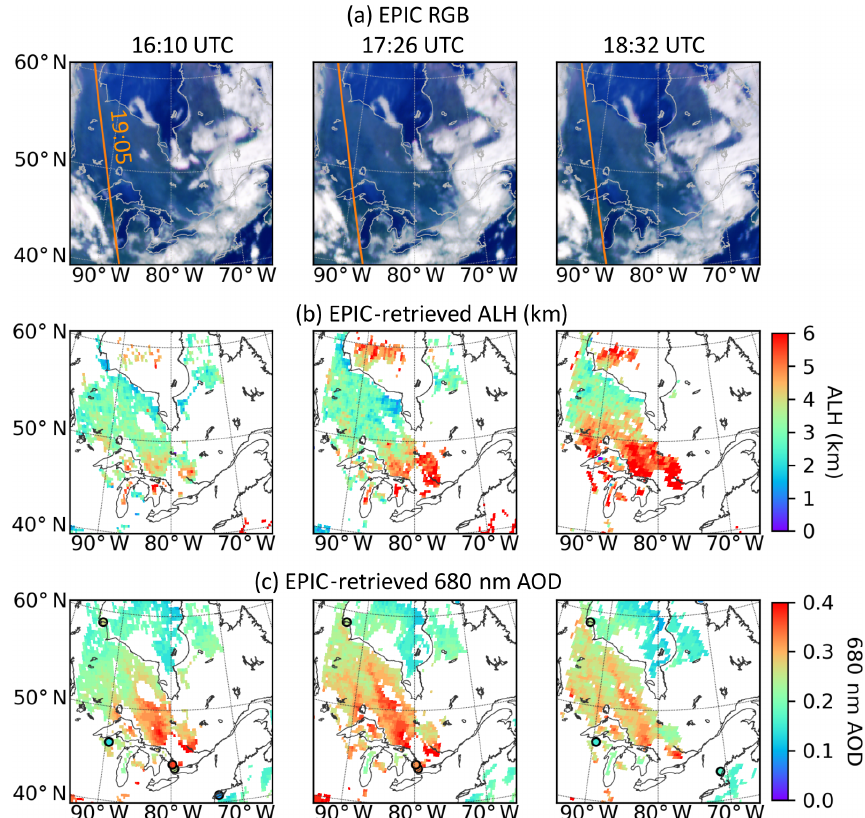
Figure 7. Demonstration of ALH and AOD retrievals for three EPIC scenes acquired on 25 August 2017 around UTC times of 16:10, 17:26, and 18:32. (a) Red–green–blue (RGB) composites of EPIC 443, 551, and 680nm data. The gold line indicates the CALIOP sub-orbital track with an overpass time of 19:05UTC. (b) Retrieved smoke ALH when 680nm AOD is larger than 0.2. (c) Retrieved 680nm AOD. Small circles on AOD maps represent AOD values observed at corresponding AERONET sites within 2h of the EPIC scan